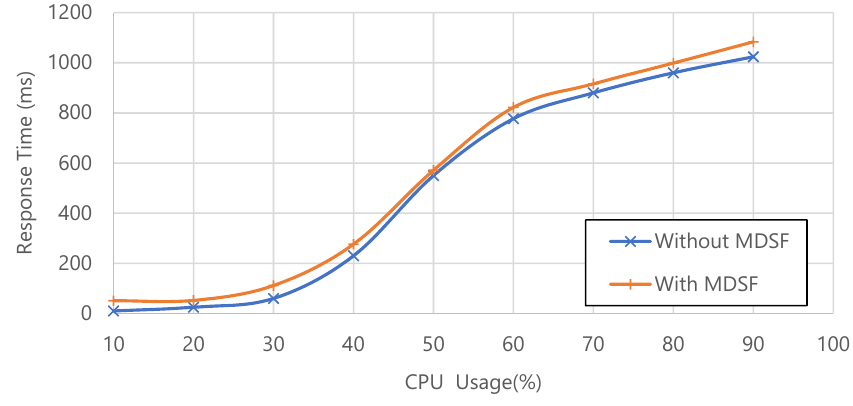
Figure 9. Microservice response time under different CPU